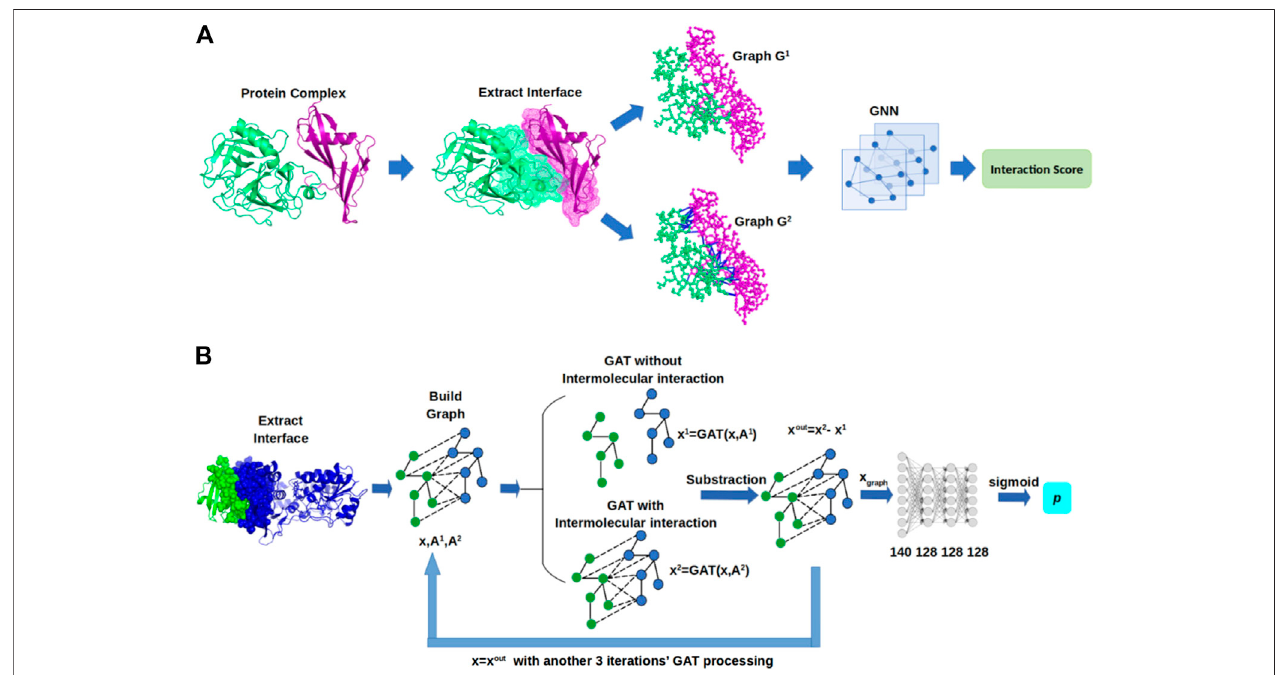
FIGURE 1 | Framework of GNN-DOVE. GNN-DOVE extracts the interface region of protein complex and further reconstructs graph with/without intermolecular interactions as input, then outputs the probability that indicates if the input structure is acceptable or not. (A) Overall logical steps of the pipeline. (B) Architecture of the GNN network with the gated graph attention mechanism.